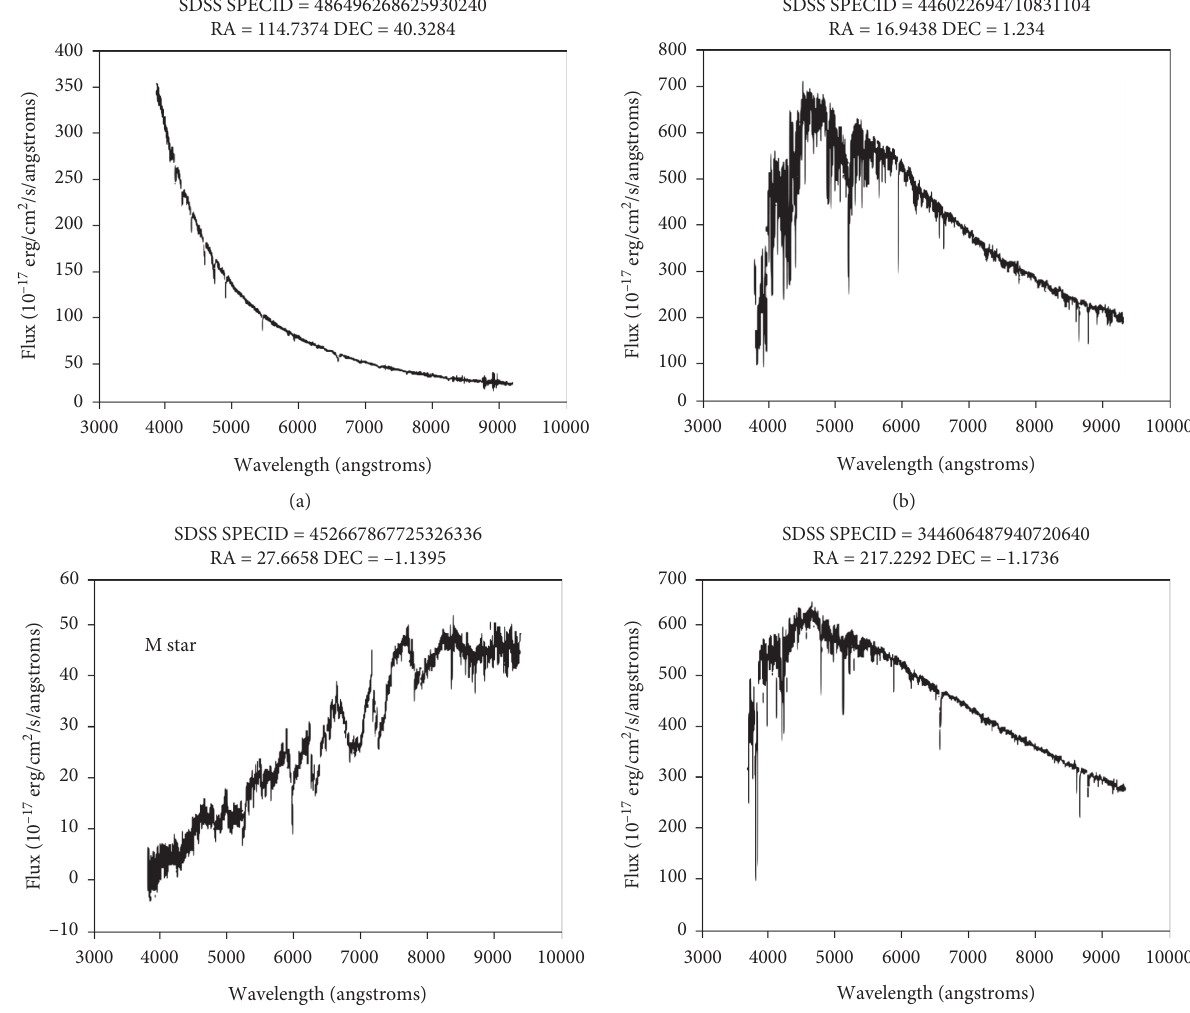
Figure 4: O-type, K-type, M-type, and F-type